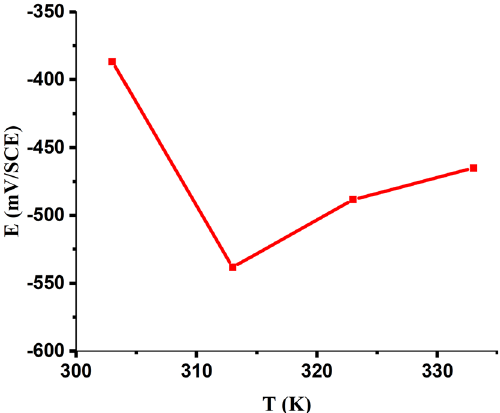
Figure 8. OCP as a function of temperature for MS in 1.0 M HCl and 0.5 mM nonanedihydrazide.